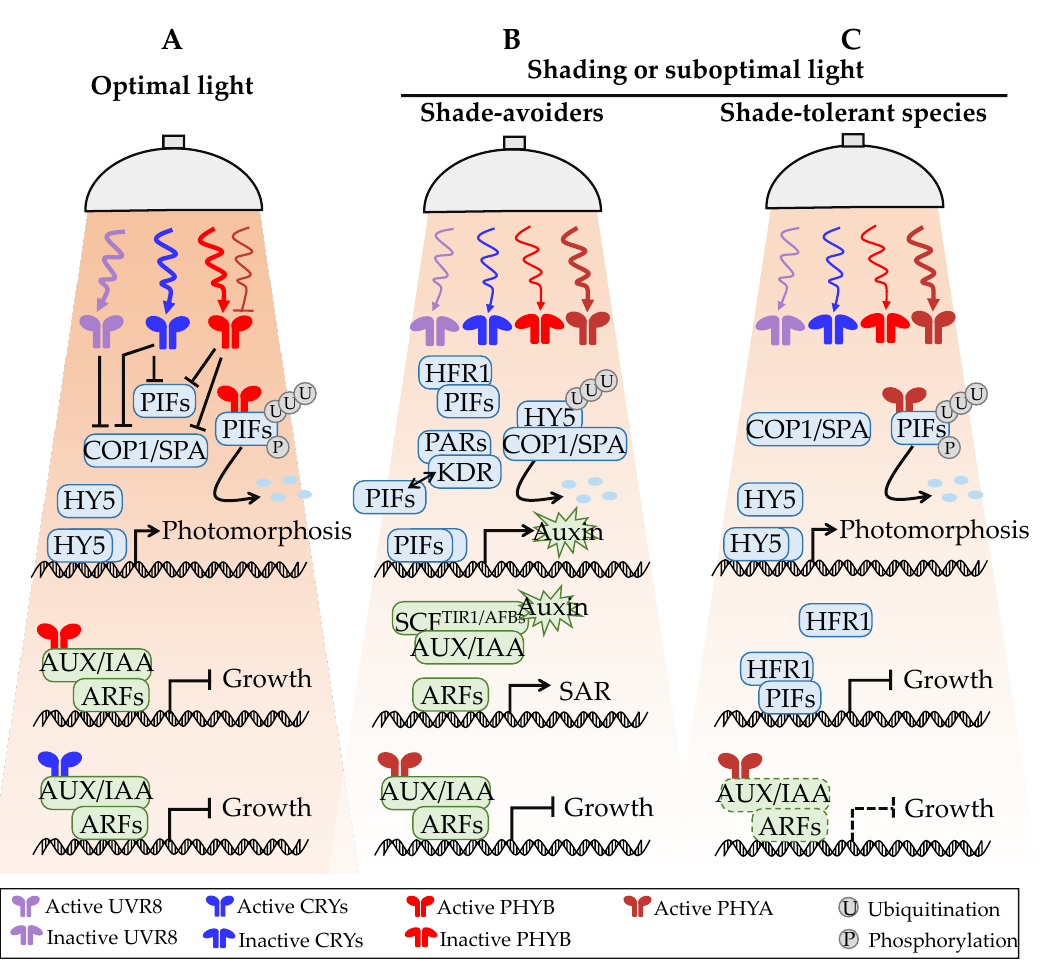
Figure 3. Mechanism of light and auxin integration in response to optimal light, shading, or suboptimal light in plants. ( A ) Photomorphogenesis of plants under optimal light distribution. ( B ) Shade-avoidance- related response (SAR) and the feedback mechanism of shade avoiders under shading or suboptimal light. ( C ) Shade-tolerance-related response (STR) mechanism of shade-tolerant species to shading or suboptimal light. Arrows indicate positive regulation, T-shaped lines indicate negative regulation. Dotted line indicates possible regulation. See main text for details. Abbreviations: PIFs, phytochrome interacting factors; COP1/SPA, constitutively photomorphogenic 1/suppressor of phytochrome A; HY5, elongated hypocotyl 5; HFR1, long hypocotyl in far-red 1; PARs, photosynthetically active radiation; KDR, KIDARI; AUX/IAA, auxin/indole-3-acetic acid; ARFs, auxin response factors; SCF, S-phase kinase-associated protein1(SKP1)-cullin1(CUL1)-F-boxprotein; TIR1/AFBs, transportinhibitorresponse1/auxinsignaling F-box proteins; UVR8, ultraviolet radiation 8; CRYs, cryptochromes; PHYA, phytochrome A; PHYB, phytochrome B; SAR, shade-avoidance-related